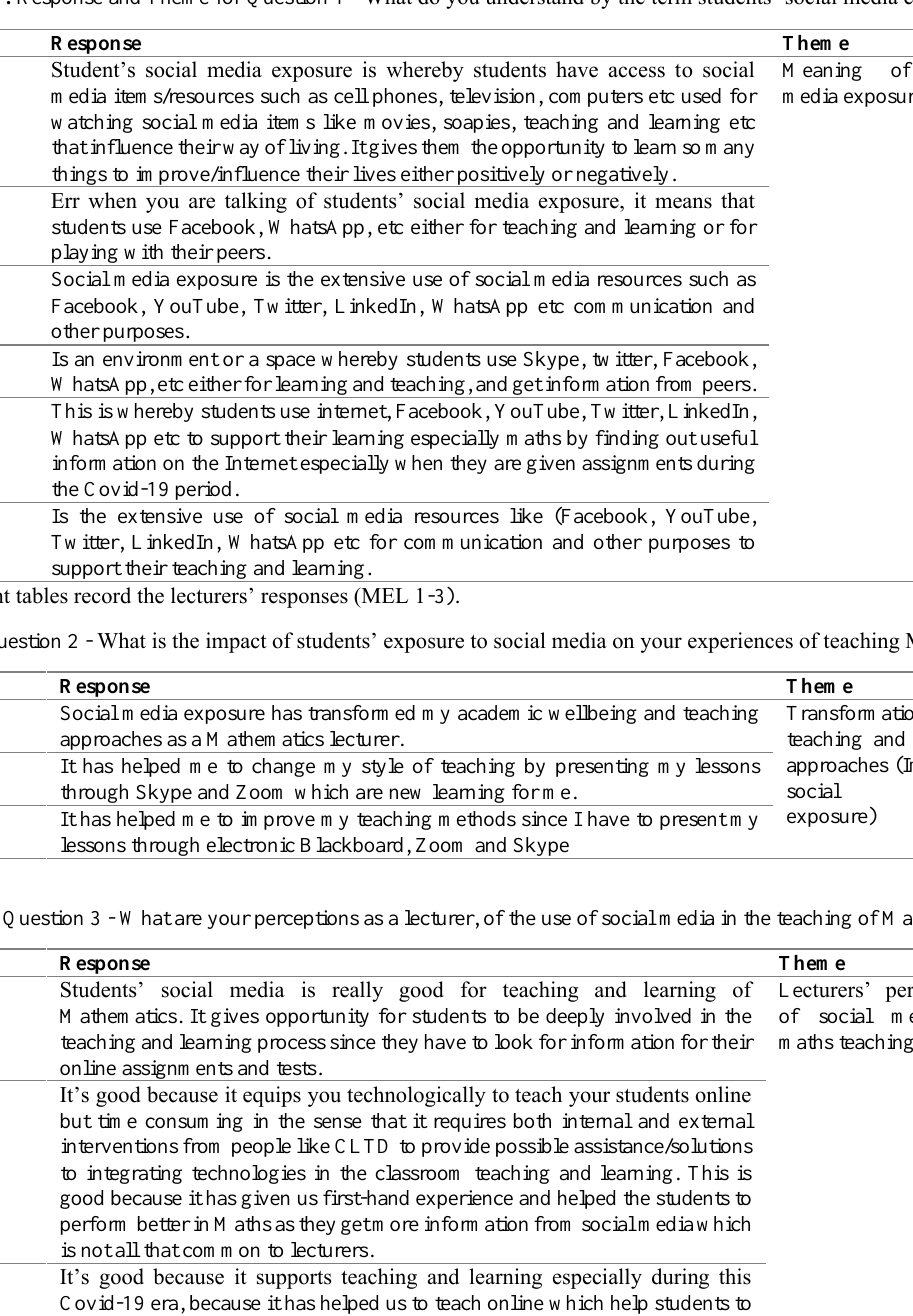
Table 1: Response and Theme for Question 1 - What do you understand by the term students’ social media exposure?